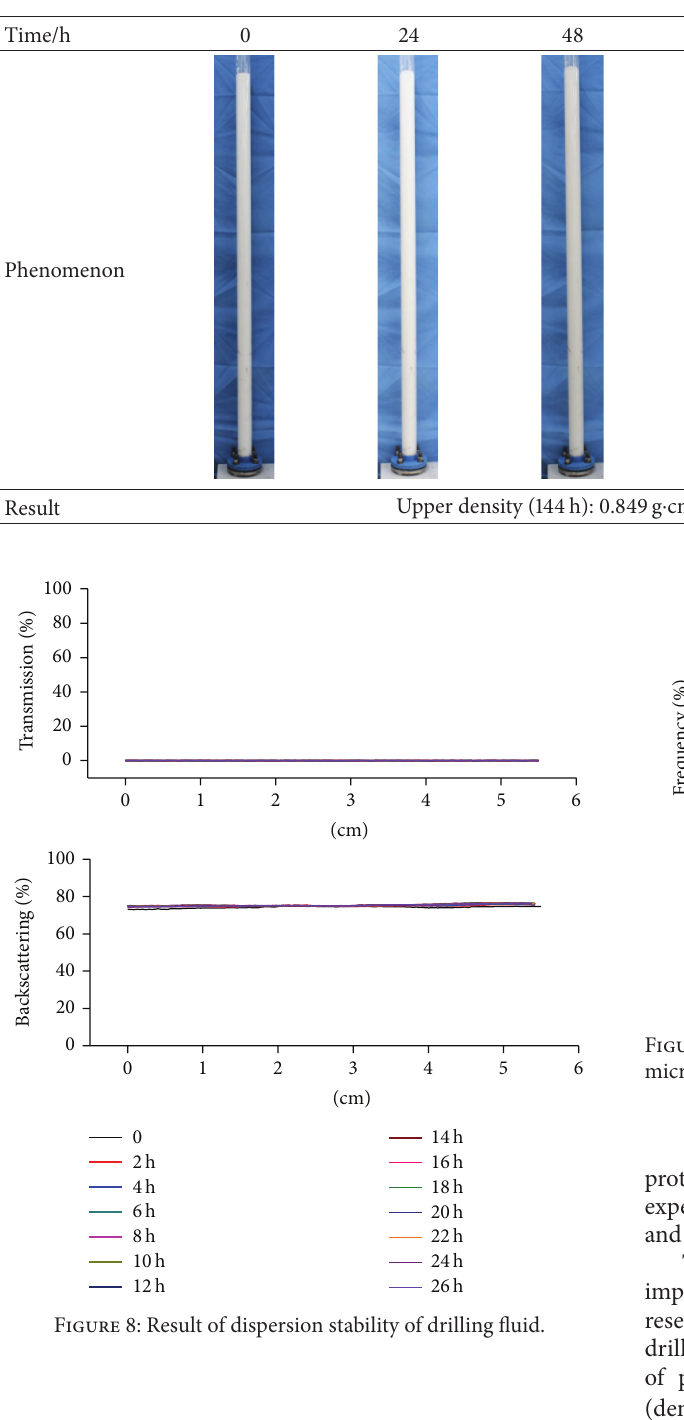
Table 5: The evaluation of sedimentation stability (method of using long plastic tube).